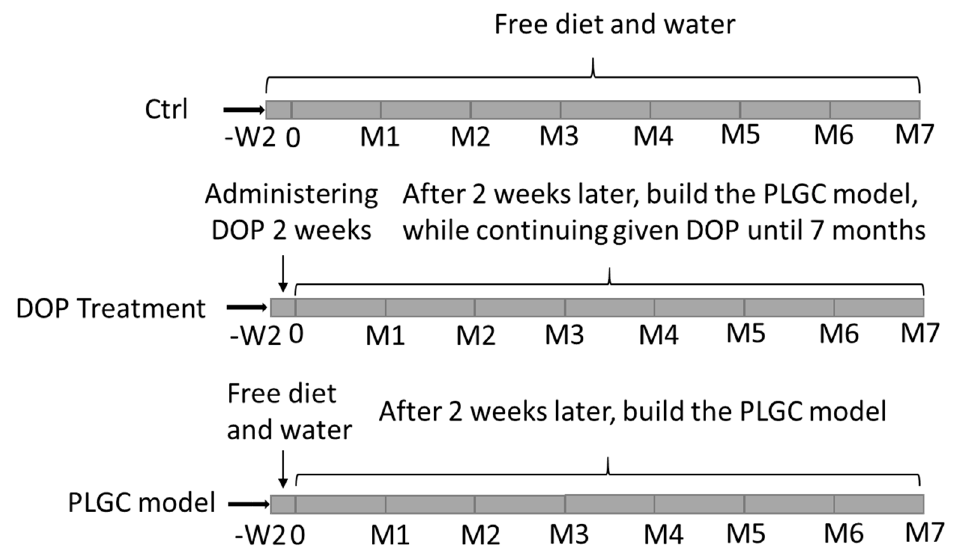
Figure 8. The diagrammatic sketch of the experiment.